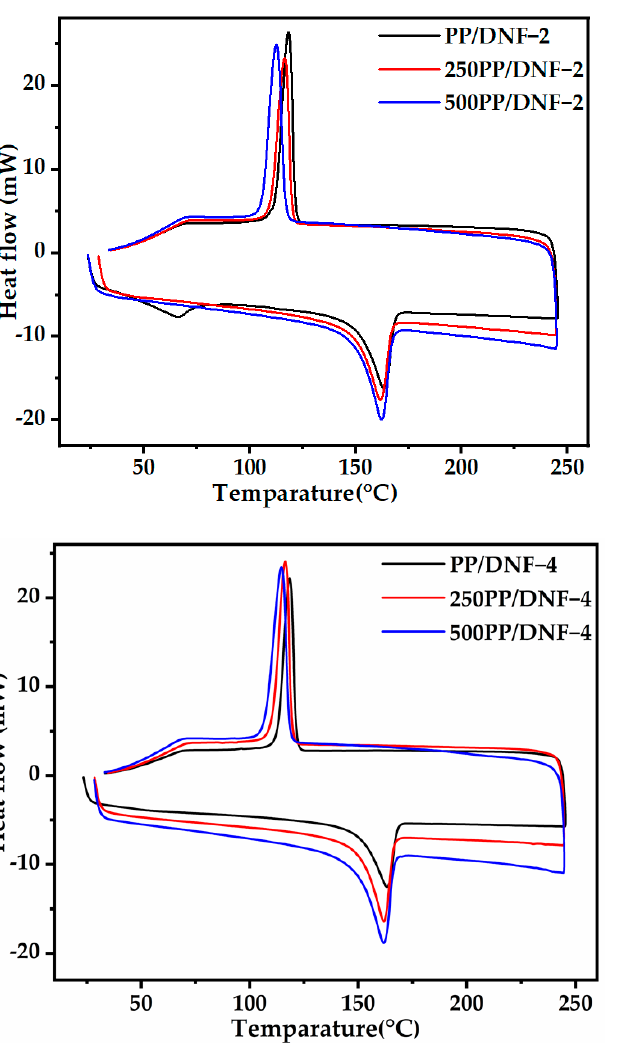
Figure 3. DSC thermogram of samples before and after weathering. Table 3. DSC characteristics of the composite samples.